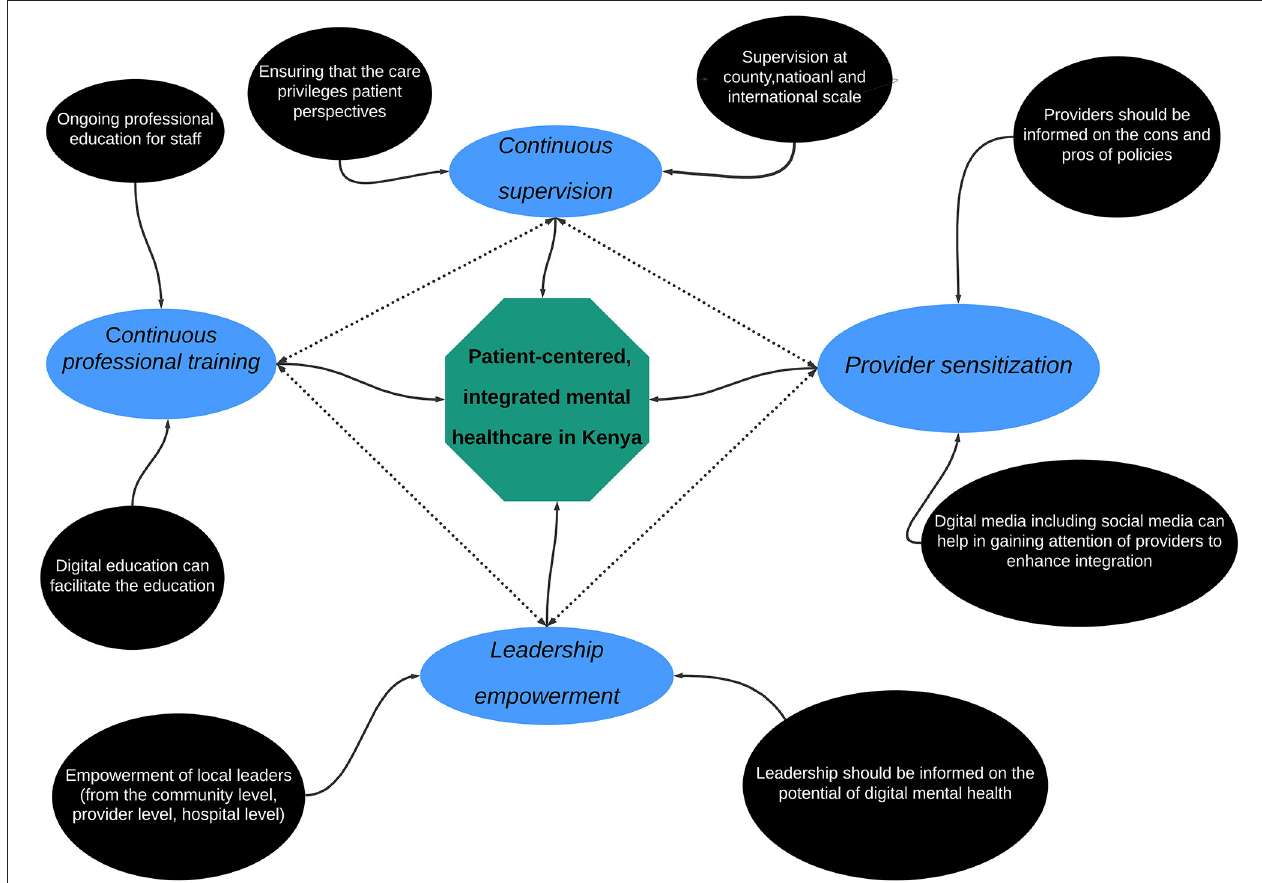
FIGURE 1 | A four-step